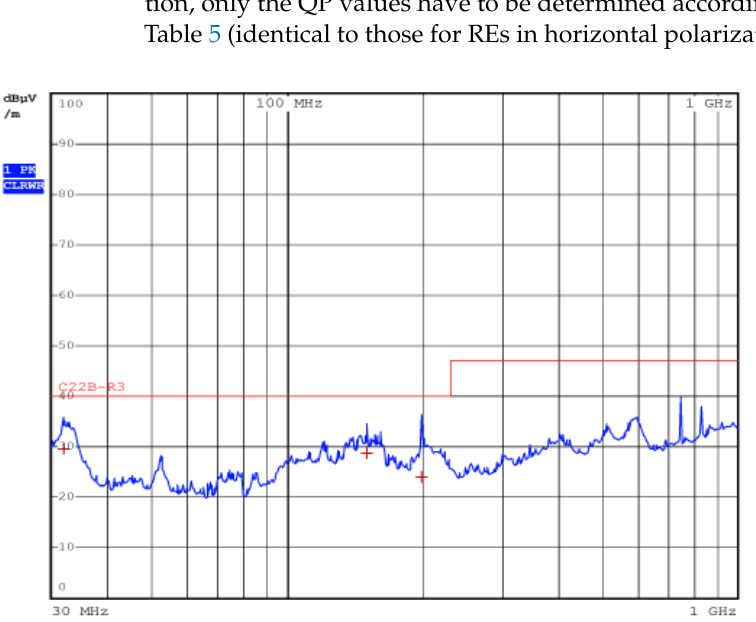
Figure 16. Radiated emissions in vertical polarization for a laptop.